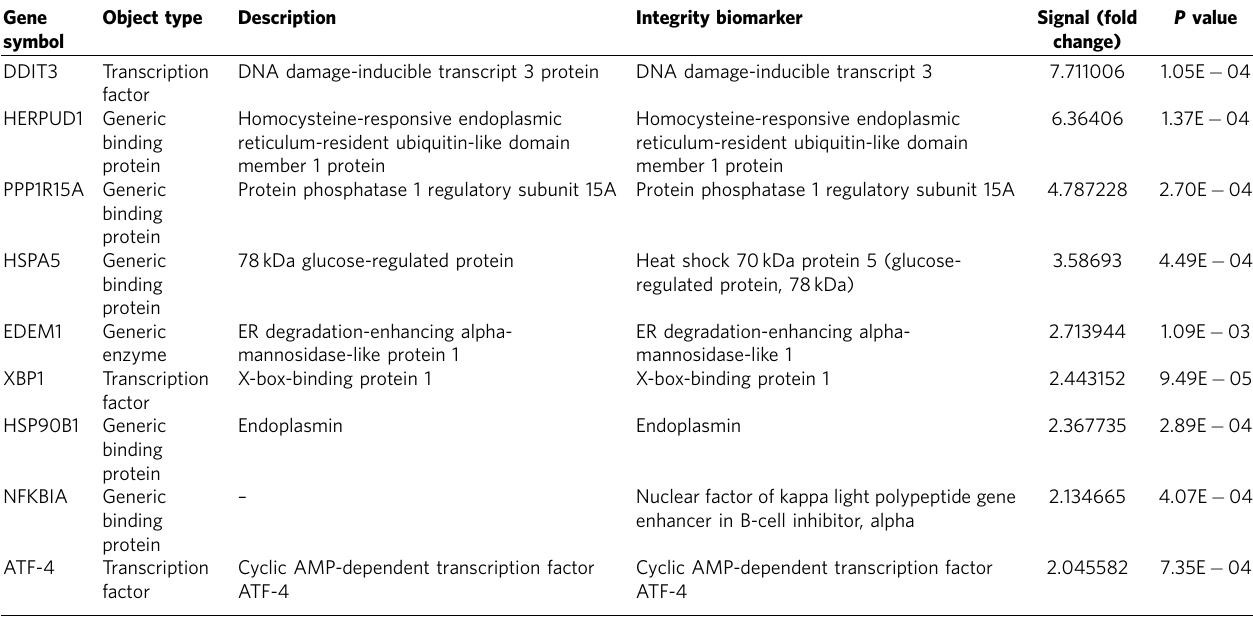
Table 4 | The endoplasmic reticulum (ER) stress response-related molecules with significantly altered